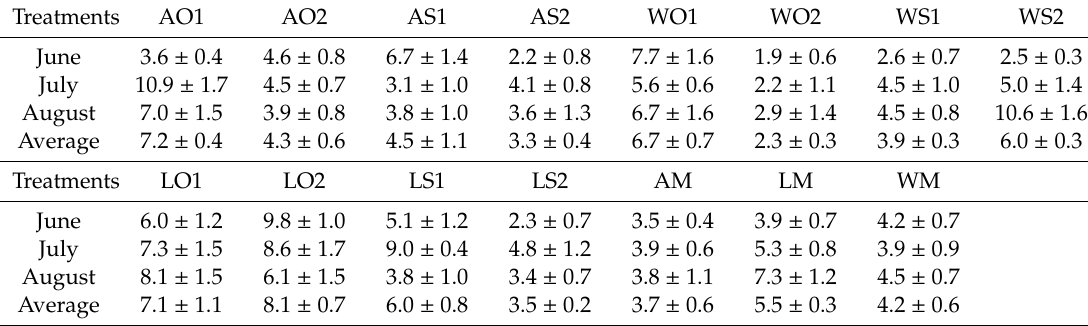
Table 5. Productivity stability of all communities during the growing period.